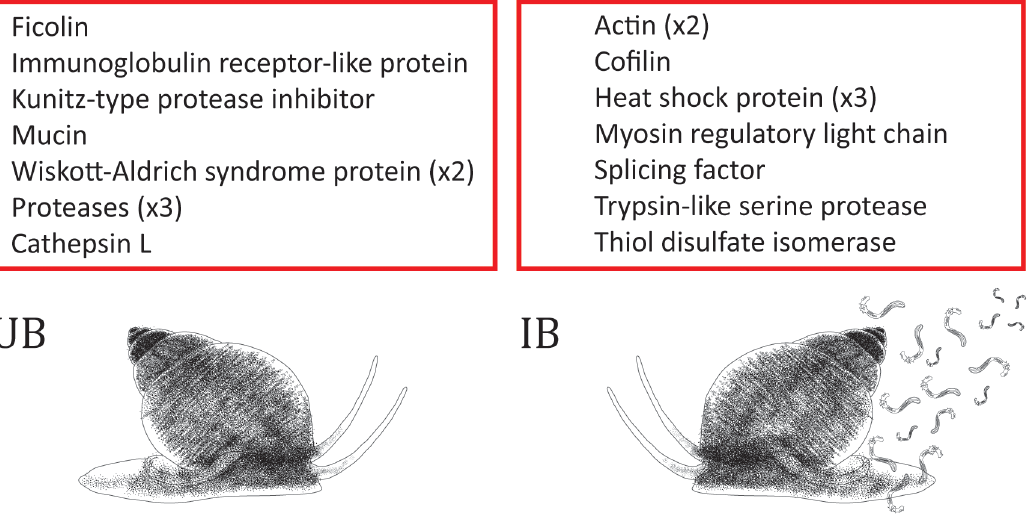
Figure 3. The top ten up-regulated genes linked to biological pathways associated to immune responses [based on orthology to molecules in the Kyoto Encyclopedia of Genes and Genomes (KEGG)] in each uninfected and Opisthorchisviverrini -infected Bithynia siamensisgoniomphalos snails (UB and IB, respectively).